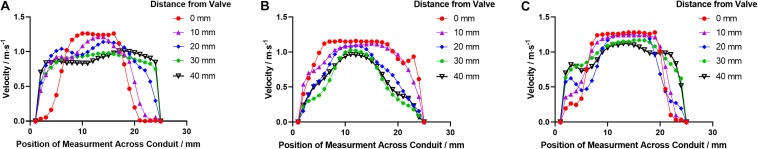
The velocity profile distributions downstream the leaflets in (A) PB1, (B) PB2, and (C) PT at t2.